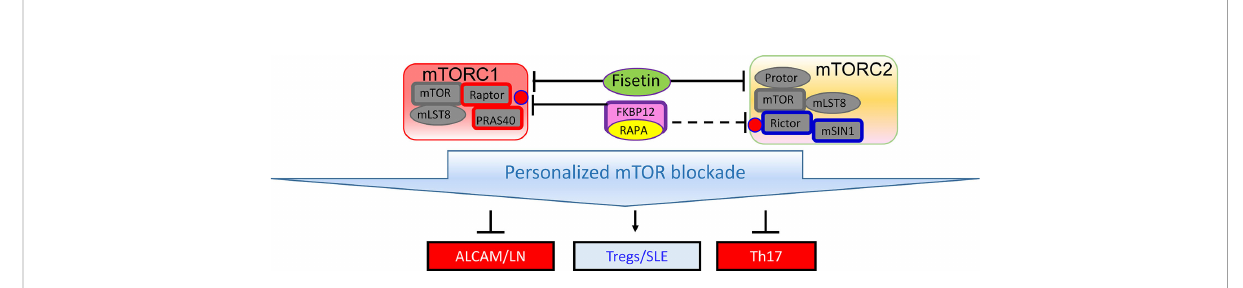
FIGURE 1 Schematic diagram of mTOR complexes 1 (mTORC1) and 2 (mTORC2) in SLE. Similar to rapamycin, fi setin inhibits both mTOR complexes (34), which may be involved in expanding Tregs (35) and thus improving depression and other organ involvement in SLE (10,